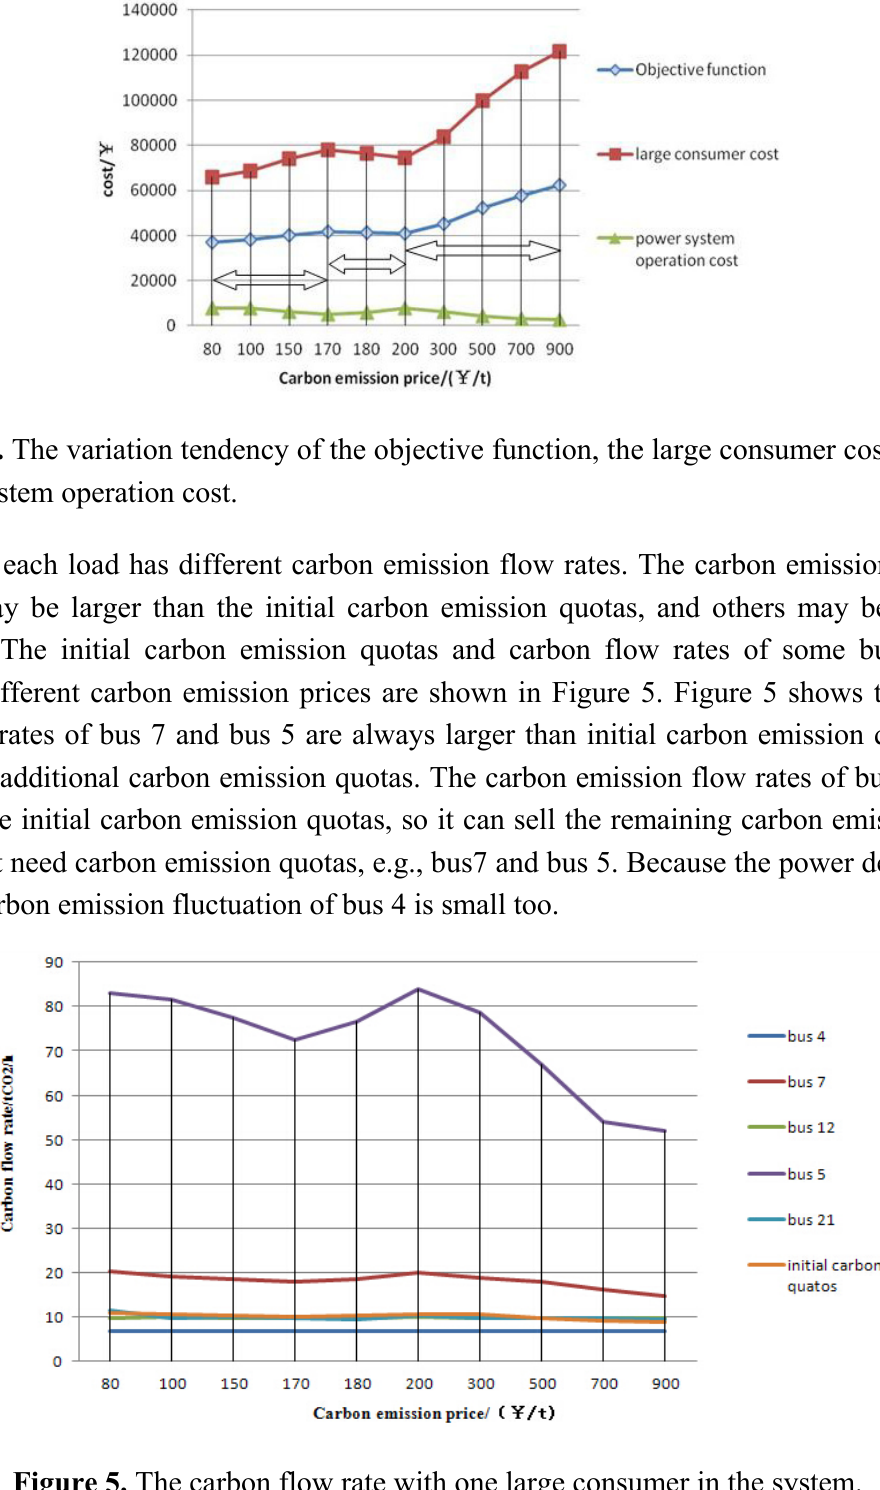
Figure 5. The carbon flow rate with one large consumer in the